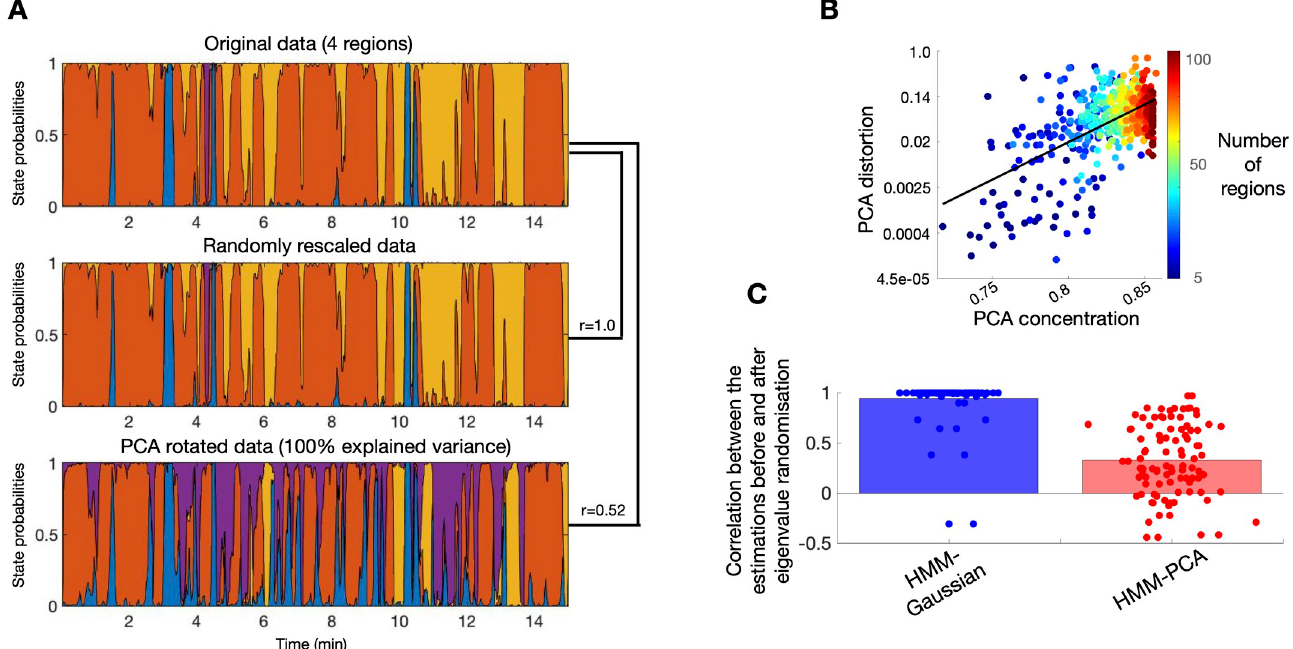
Fig 3. PCA introduces an estimation bias on the HMM or mixture model. A . The HMM inference is scale-invariant, but not PCA-rotation-invariant. State time courses produced by the HMM inference for one HCP subject on the original parcellation space (top), after applying a random scaling of the data (middle), and after PCA rotation with no loss of variance (bottom). Each colour represents a different state, so that the coloured areas indicate the probability of activation for the states across the session. The similarity between the different runs, expressed as Pearson’s correlation coefficients, are expressed on the right. B . The extent of this bias (PCA distortion) is logarithmically related to how concentrated is the variance on the first PCs (PCA concentration); that is, the more correlated are the regions on the original data, the stronger will be the bias introduced by PCA. C . Random manipulations of the data eigenvalues are correctly reflected as changes in the HMM-PCA estimations; HMM-Gaussian is not able to capture the